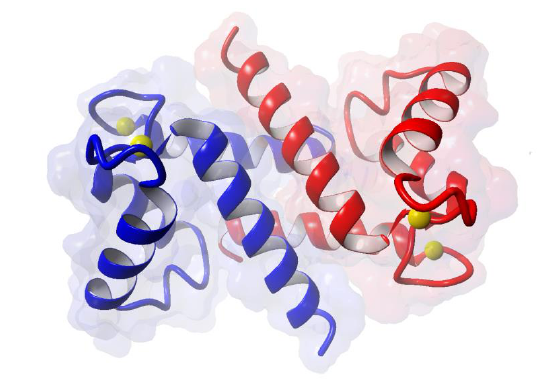
Figure 1. Structure of S100A6 dimer loaded with 4 Ca 2+ (Protein Data Bank id:1K96) [3]. Each color, blue and red, represents one monomer; yellow balls represent Ca 2+ .